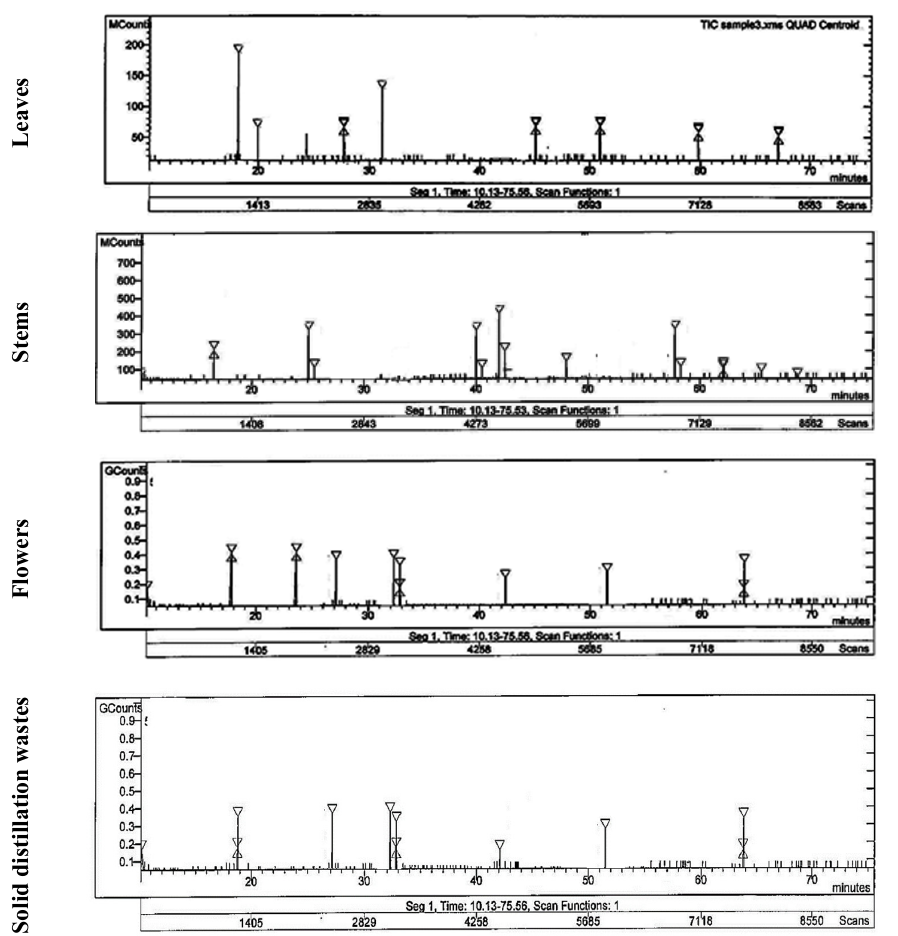
Figure 3. HPLC analysis of the alkaloid compounds in the different organs as well as the solid dis ‐ tillation wastes of Taif’s rose collected from Al ‐ Shafa highlands in Taif City, Saudi